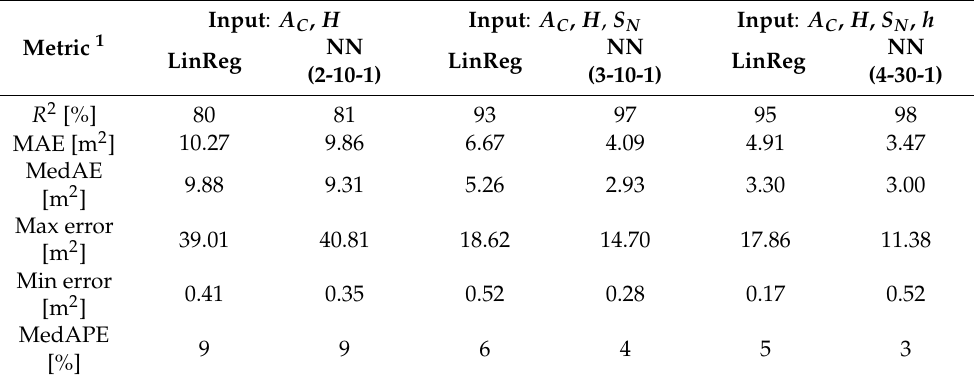
1 Used metrics: R 2 coefficient, mean absolute error (MAE), median absolute error (MedAE), max and min error, median absolute percentage error (MedAPE).